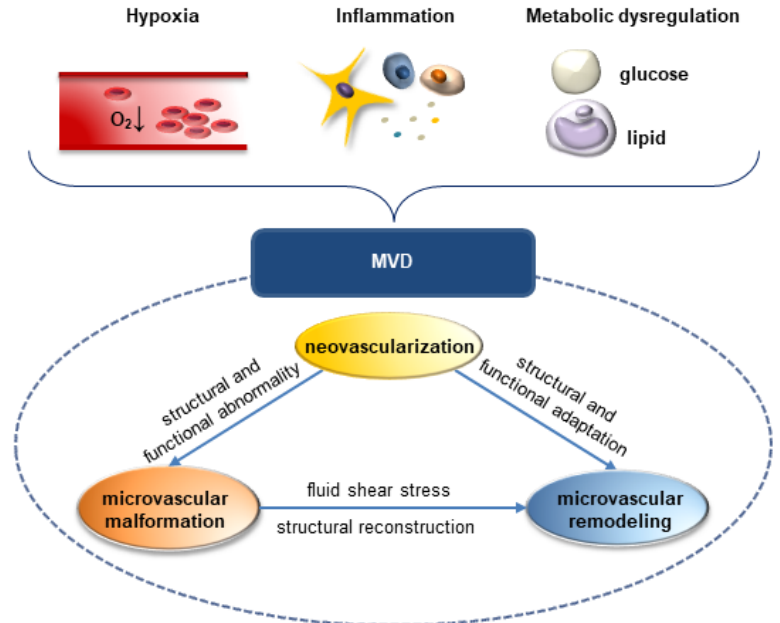
Figure 1. Pathogenic factors and pathological processes of MVD. Pathogenic factors, such as hypoxia, inflammation, and metabolic dysregulation, contribute to MVD. Pathological processes of MVD include neovascularization, microvascular malformation, and microvascular remodeling. Both neovascularization and microvascular malformation can be structurally and functionally remodeled in response to physical and chemical stimuli.